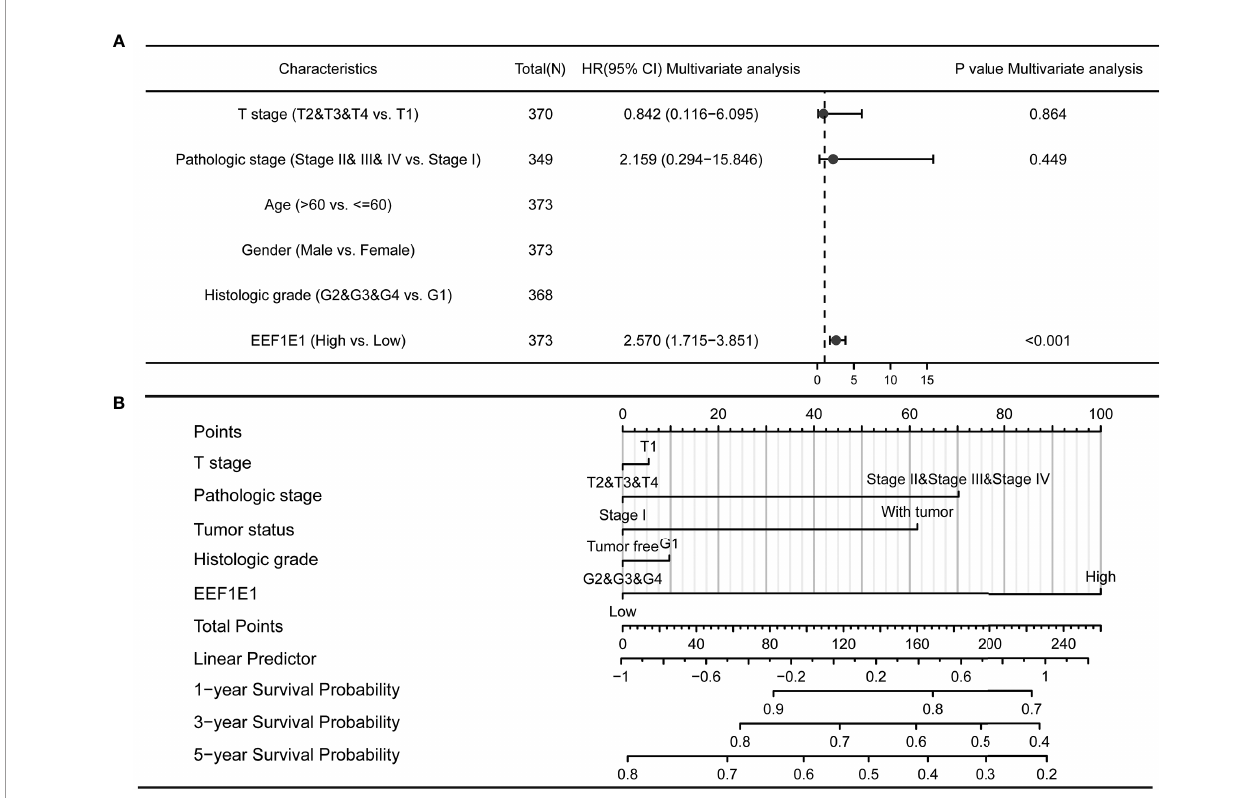
FIGURE 5 | Forest map and nomogram map showed the correlation between EEF1E1 expression and prognosis. (A) Forest map showed the correlation between EEF1E1 expression and prognosis. (B) Nomogram map showed the correlation between EEF1E1 expression and prognosis.